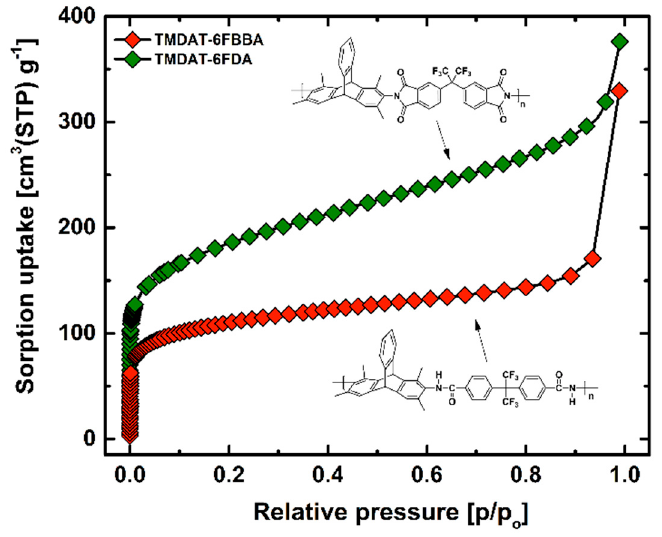
Figure 6. N 2 sorption isotherms at 77 K of the 6FBBA-TMDAT polyamide and 6FDA-TMDAT polyimide [45].